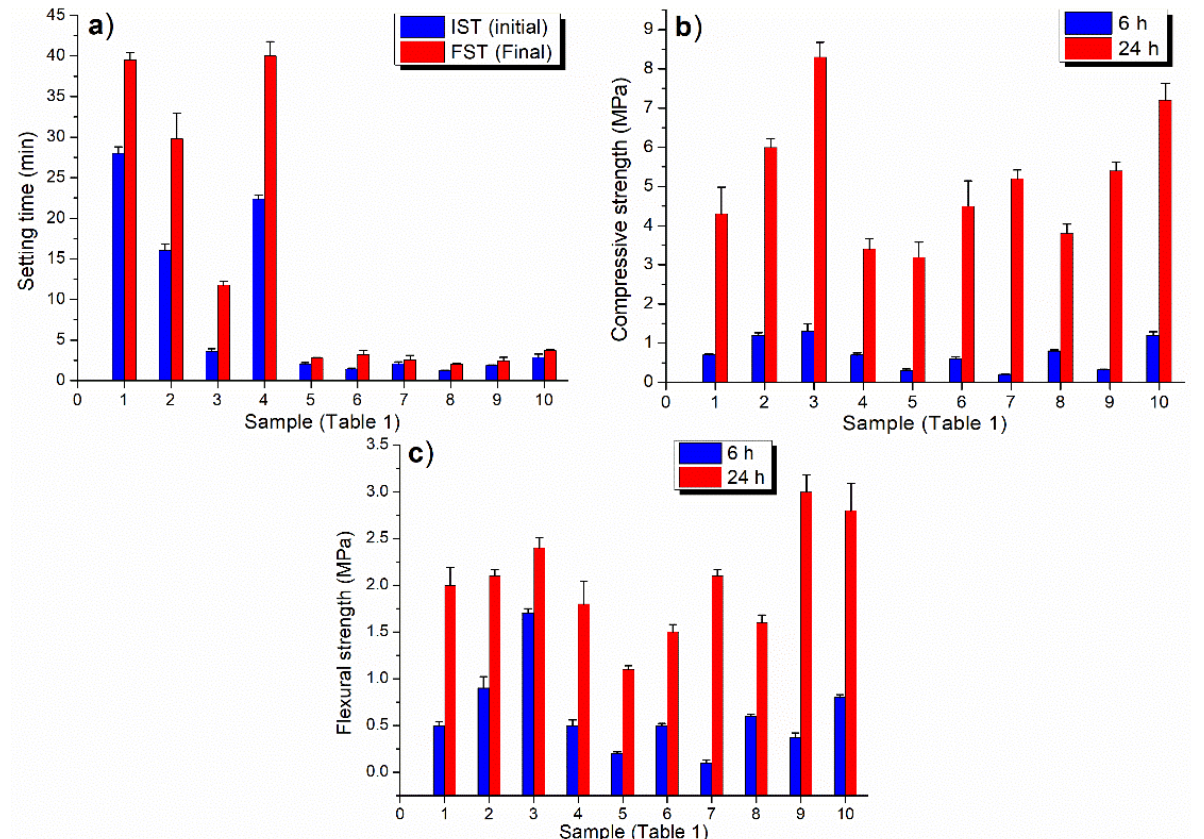
Figure 1. Histograms for the setting time of cement ( a ) and the mechanical strength of mortar ( b , c ) with SD bars under a different regulator.